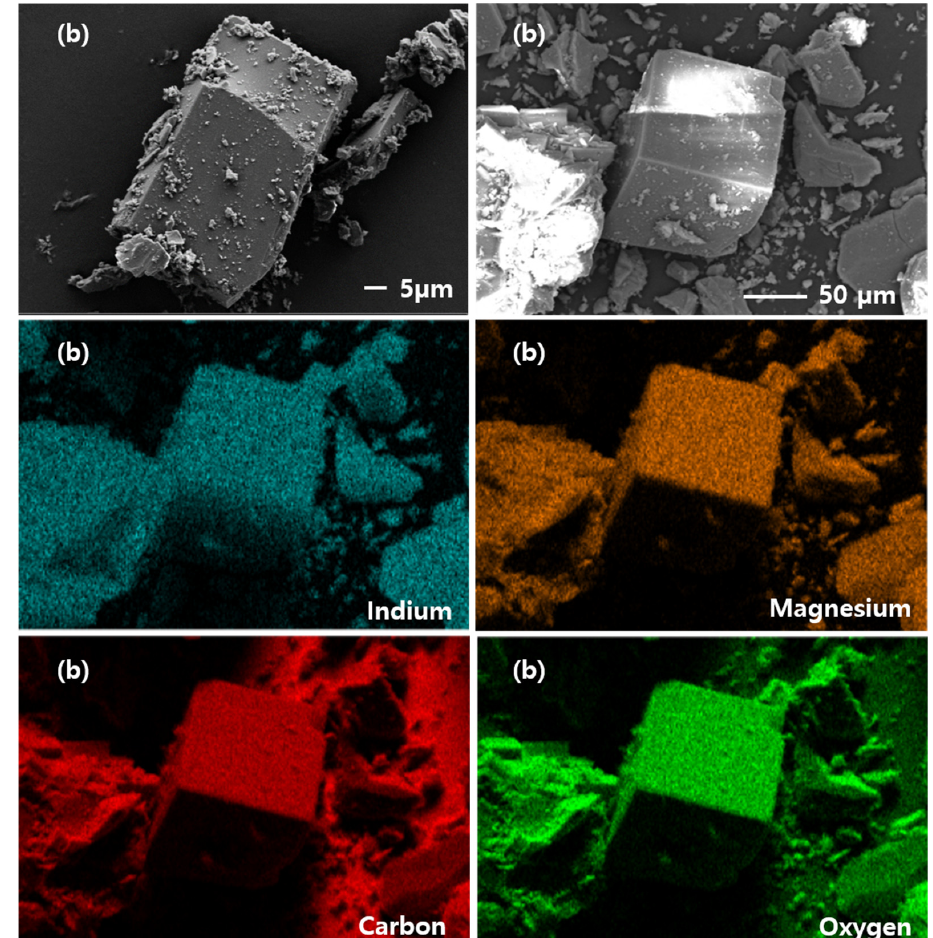
Figure 2. SEM-EDS image of synthesized catalysts: ( a ) CPM-200-In and ( b ) CPM-200-In/Mg.